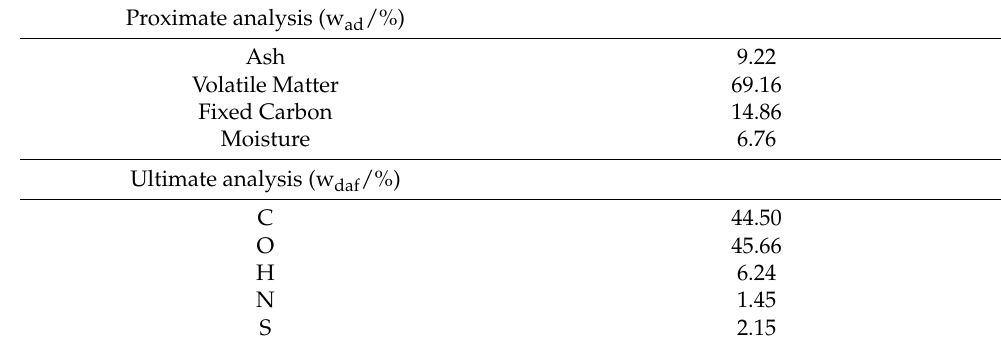
Table 5. Properties of rice straw [24].